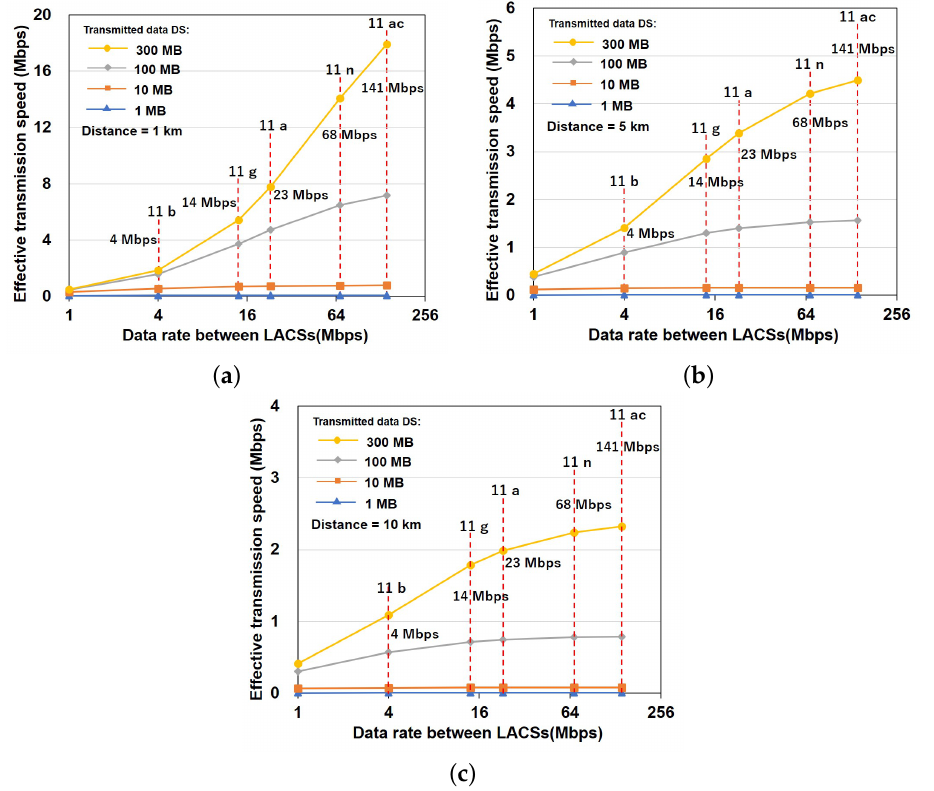
Figure 12. Comparison of Effective transmission speed on IEEE 802.11 protocols. UAV’s velocity = 10 m/s. ( a ) Effective transmission speed at 1 km. ( b ) Effective transmission speed at 5 km. ( c ) Effective transmission speed at 10